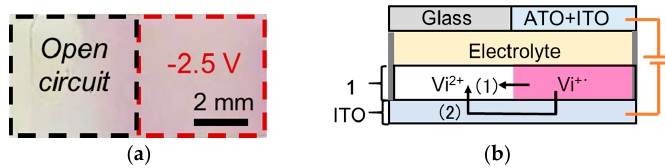
Figure 5. ( a ) Photograph of an electrochromic cell with smudging phenomenon. − 2.5 V was applied in a red dashed rectangle area for 30 s. 1 M LiCF 3 SO 3 in γ -Butyrolactone (GBL) was used as electrolyte solution; ( b ) Structure of an electrochromic device with a partially etched counter electrode.